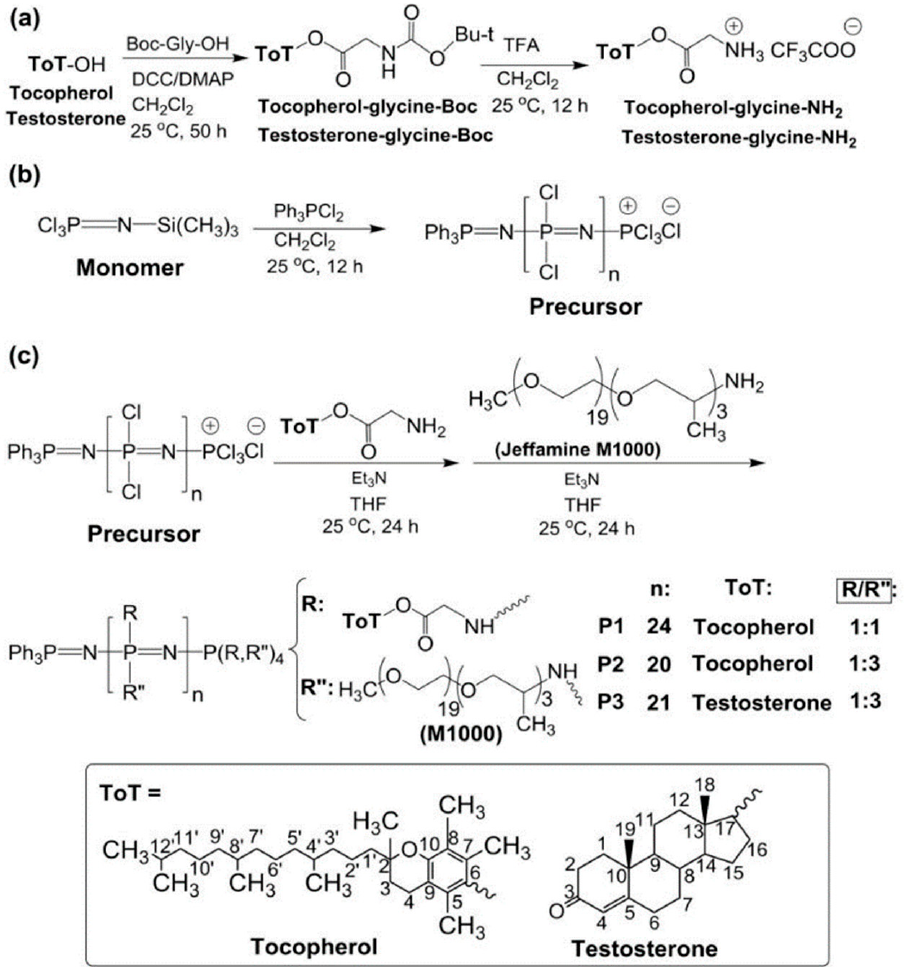
Figure 4. ( a ) Synthesis of tocopherol and testosterone glycinates (ToT-glycine-NH 2 ). ( b ) Polymerization of trichlorophosphoranimine to obtain poly(dichloro)phosphazene. ( c ) Post-polymerization process of chlorine atoms with ToT-glycine-NH 2 and Jeffamine M1000. Copyright 2022 Licensee MDPI, Basel, Switzerland, under the terms and conditions of the Creative Commons Attribution (CC BY) license (https://creativecommons.org/licenses/by/4.0/, accessed on 18 October 2022) [40]. A pH-sensitive, dual anti-cancer drug delivery carrier was prepared by Örüm et al. They synthesized a PPZ nanosphere that contain curcumin and quercetin through a one-pot drug self-framed precipitation polymerization method. Curcumin and quercetin were used as monomers in the synthesis process. The controlled drug release profile was observed in lysosomal pH (pH 5.5) and blood pH (pH 7.4) at 37 ◦ C. The release rates of quercetin and curcumin from nanospheres were 18.14% and 2.25%, respectively, in pH 7.4 at 7 days. At an acidic pH (pH 5.5), the release rates of quercetin and curcumin were 10.12% and 1.02%, respectively, at 7 days